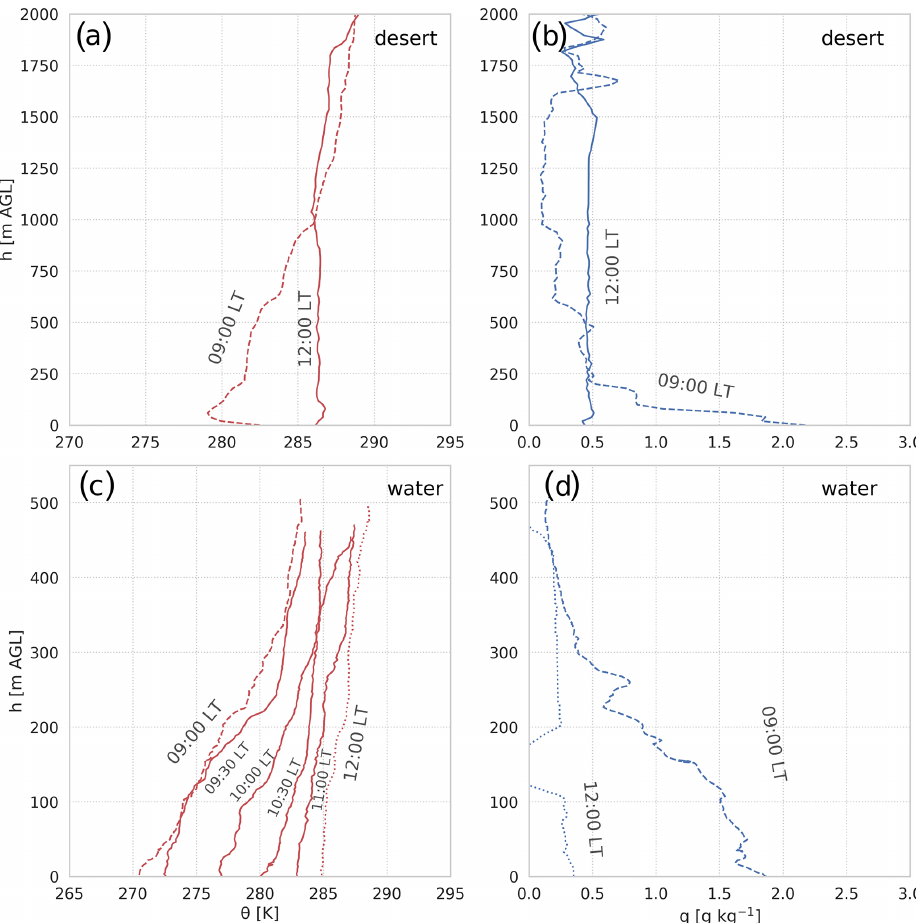
Figure 5. Morning vertical profiles of potential temperature ( θ ) and specific humidity ( q ) over the desert surface ( a and b ) for 20.35 ◦ S, 69.90 ◦ W at 3931ma . s . l . in 22 November 2018 and over water surface ( c and d ) for 20.27 ◦ S, 68.88 ◦ W at 3790ma . s . l . on 21 November 2018. Table 3. The local (surface fluxes), non-local (entrainment flux) and regional (advection) contributions of ∂q/∂t and ∂θ/∂t (Eqs. 3 and 4) corresponds to the period between 15:00 and 18:00LT. These contributions are therefore averaged over this period and were taken above desert and water surfaces. Note that observations above the desert follow satisfactorily the assumptions of the mixed-layer Eqs. (3) and (4). Total tendencies, local and non-local contributions are based on SEB stations and radiosounding measurements, whereas advective contributions are estimated as a residual of Eqs. (3) and (4) (see computation details in Appendix C). h ∂q/∂t Local Non-local Regional ∂θ/∂t Local Non-local Regional Desert